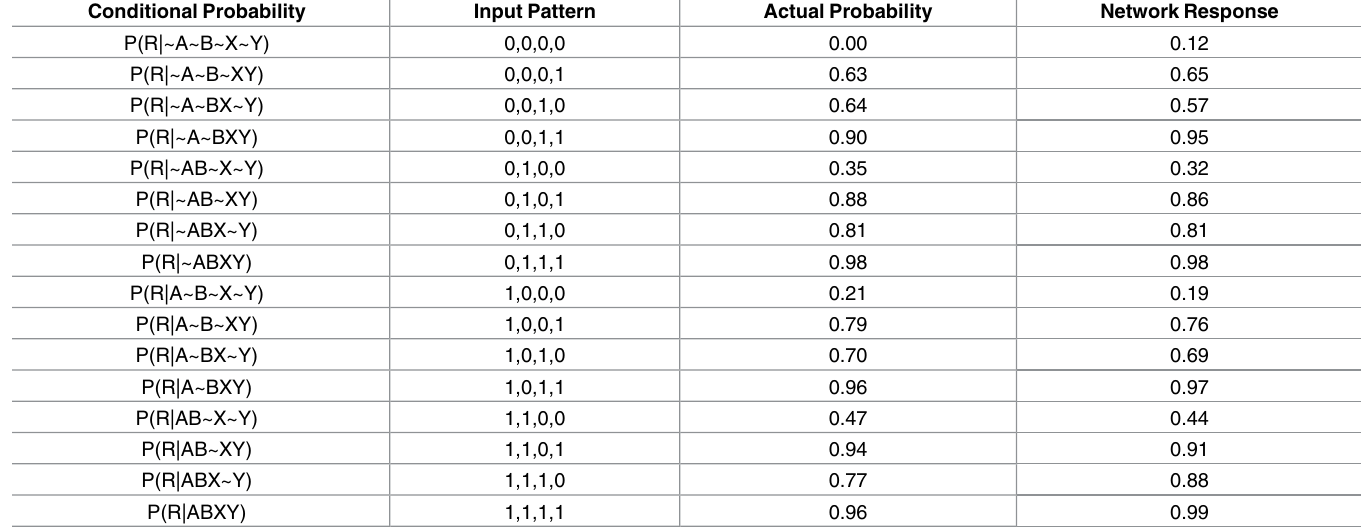
Table 1. Relation between the actual probability associated with each type of input pattern in one training set and a typical network’s responses to the